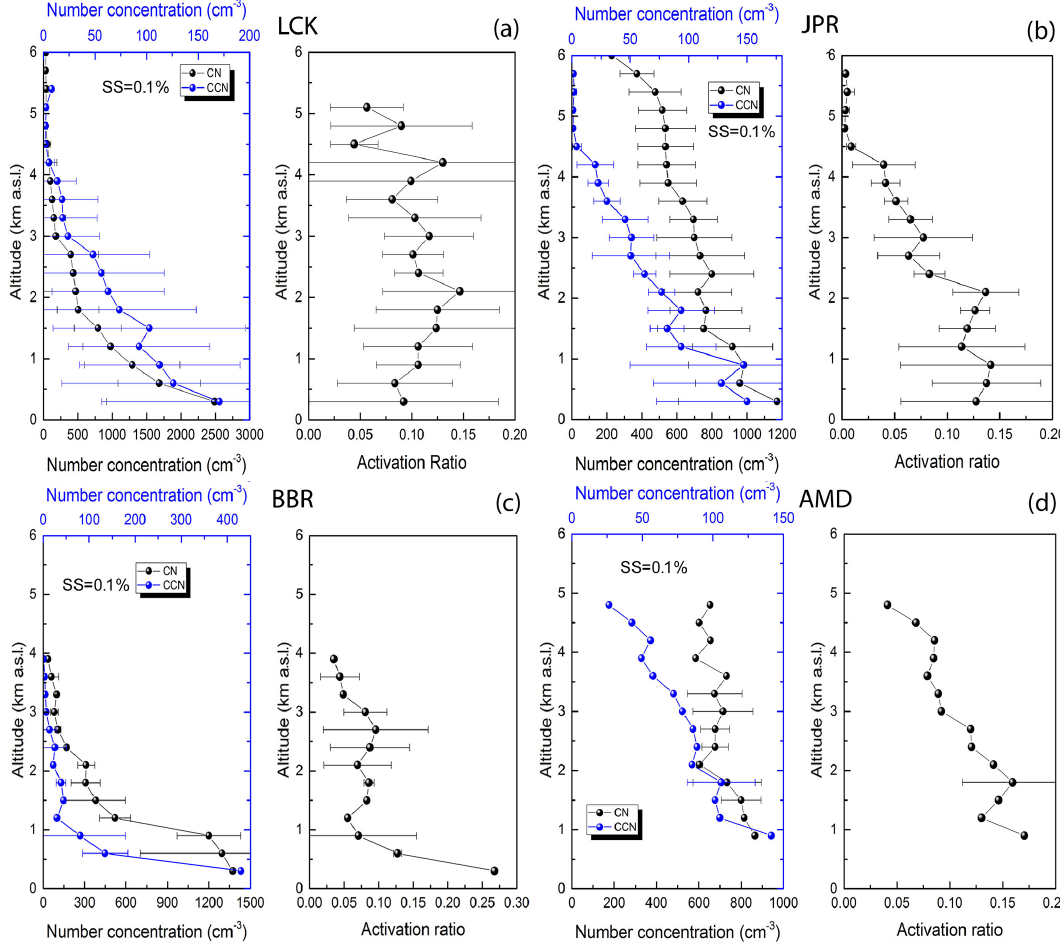
Figure 6. The number concentrations of the CN, CCN and AR over LCK, JPR, BBR and AMD are shown in (a) , (b) , (c) and (d) respectively. The activation ratio represents the fraction of total aerosols which can be converted to CCN at 0.1%